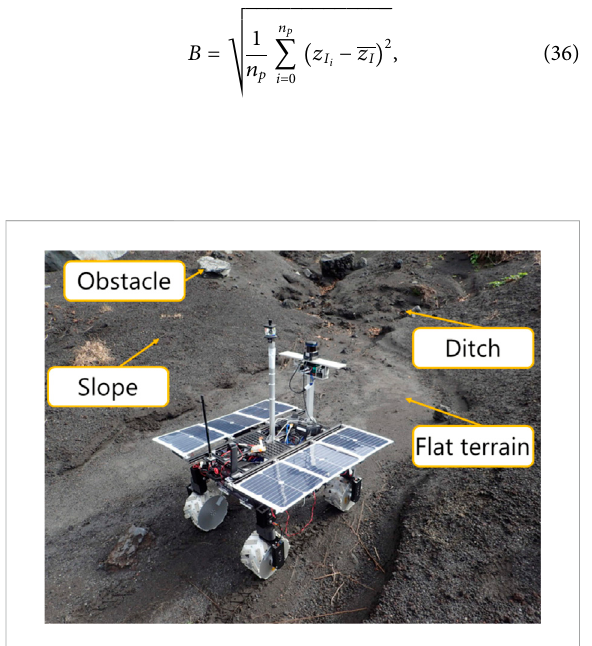
FIGURE 8 Gimbaled LiDAR scanning system for 3D terrain mapping.